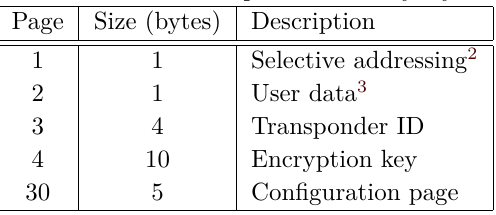
Table 2: DST80 transponder memory